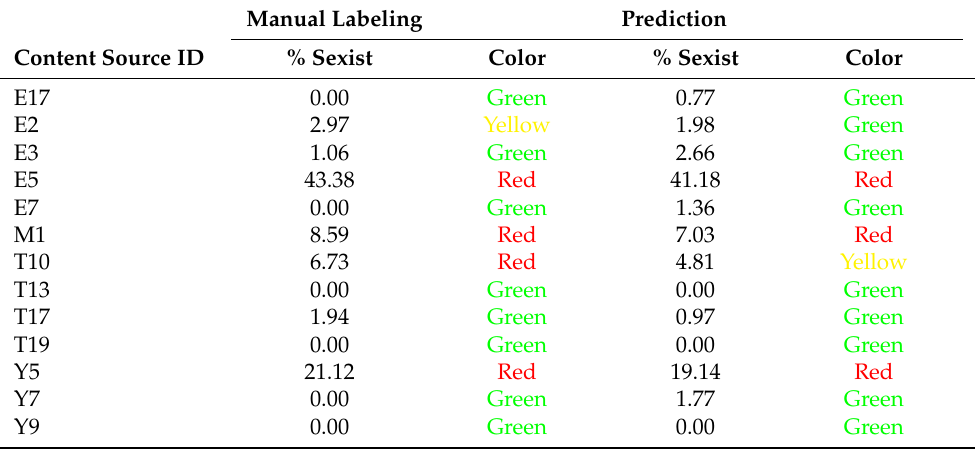
Table 4. Results of color-based anti-sexism alert system. The content source ID is detailed in Table A1. Manual